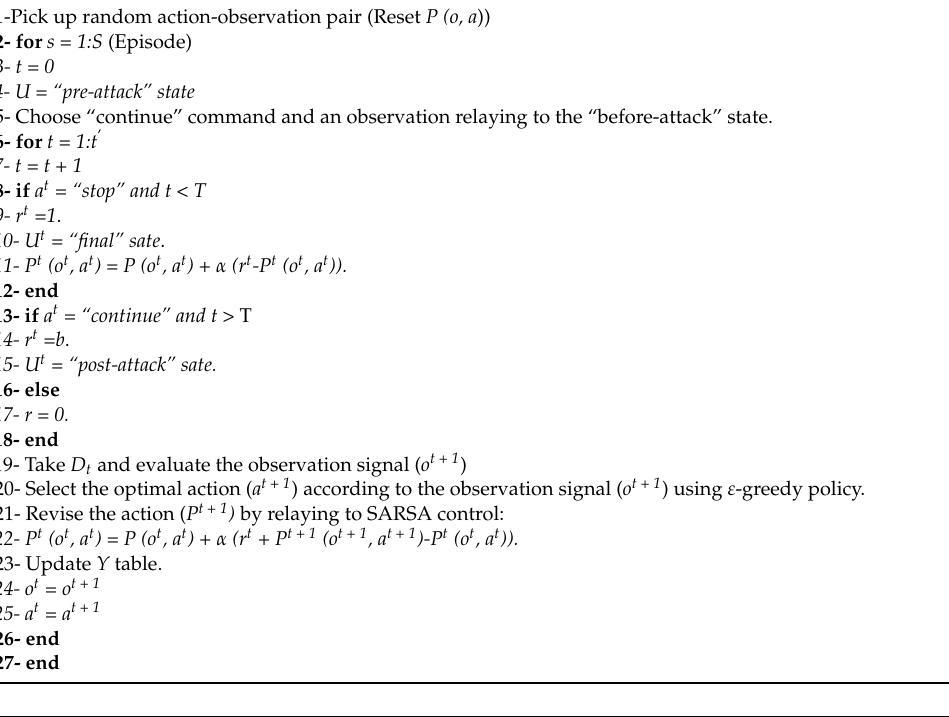
Algorithm 1: Learning phase framework.